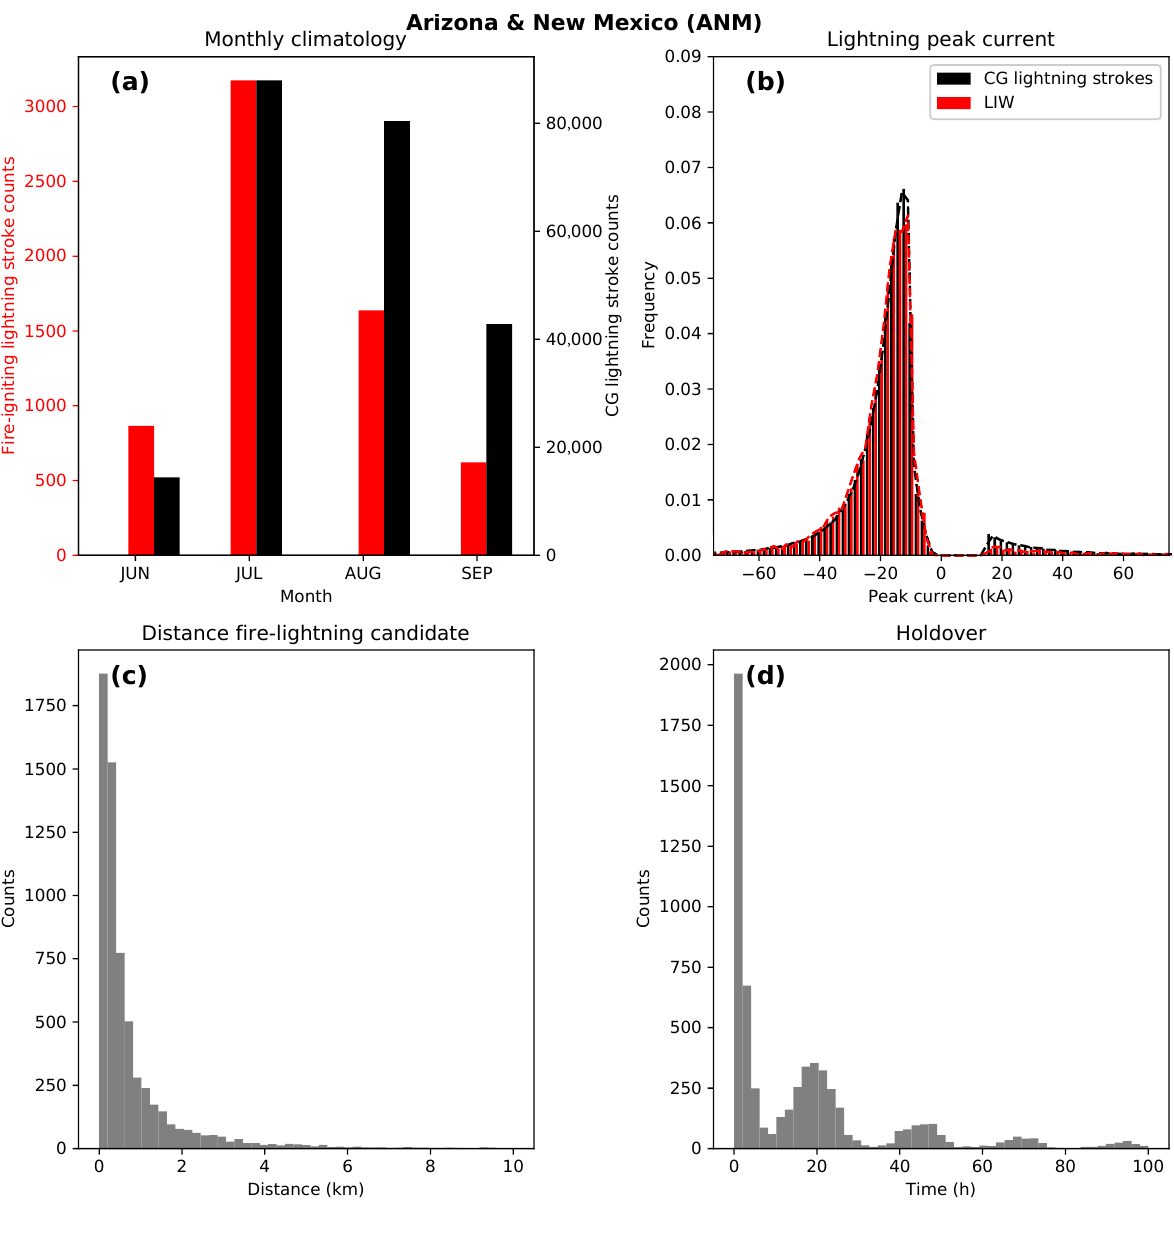
Figure 2. LIW in Arizona and New Mexico between 2009 and 2013: ( a ) Monthly distribution of the occurrence of total LIW and CG strokes over ponderosa pine and pinyon-juniper woodlands. ( b ) Frequency distribution of the peak currents of all CG strokes taking place over ponderosa and pinyon-juniper woodland forests in June and September (black) and of all fire-igniting lightning flashes (red) detected with NLDN. ( c ) Distribution of the distance between the reported position of ignition and the lightning candidate. ( d ) Distribution of the